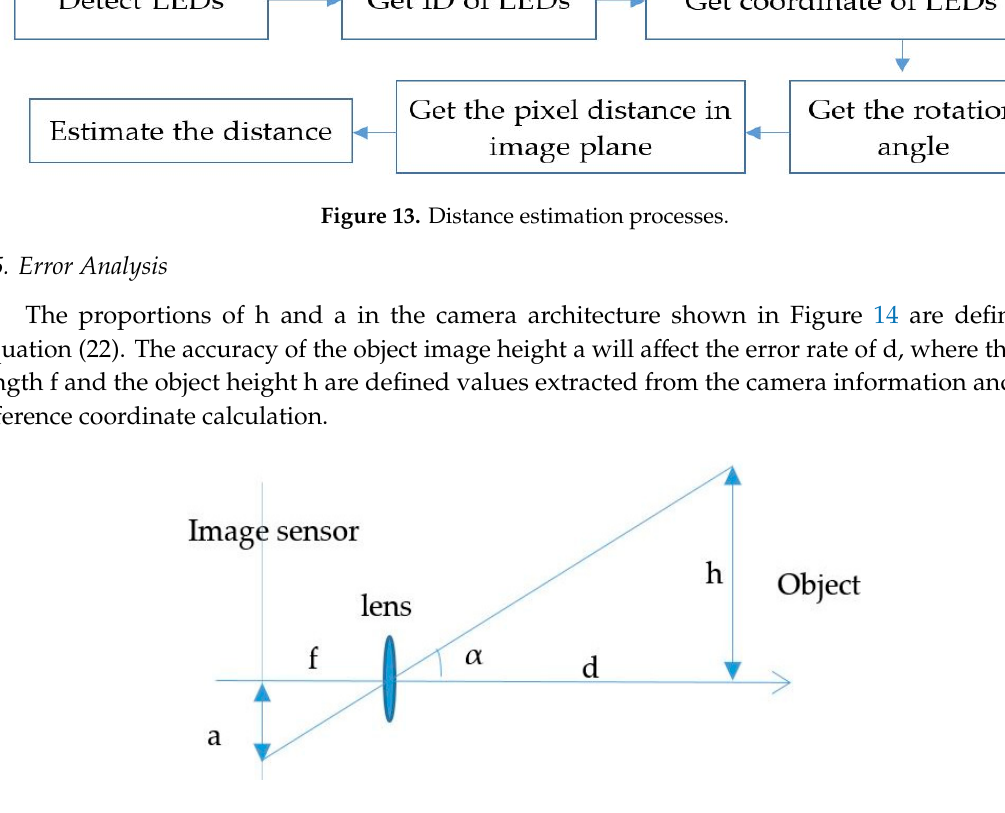
Figure 12. Rolling image sensor operation. Figure 13. Distance estimation processes.